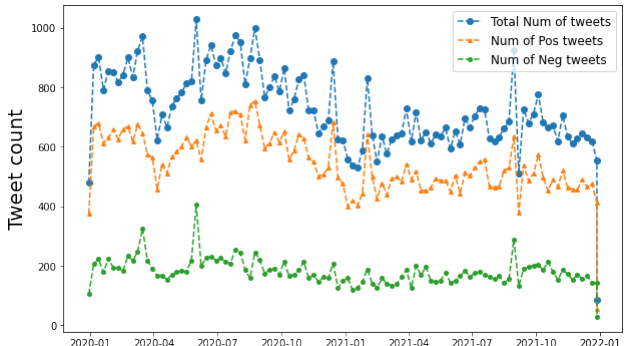
Figure 8. Private vehicle.